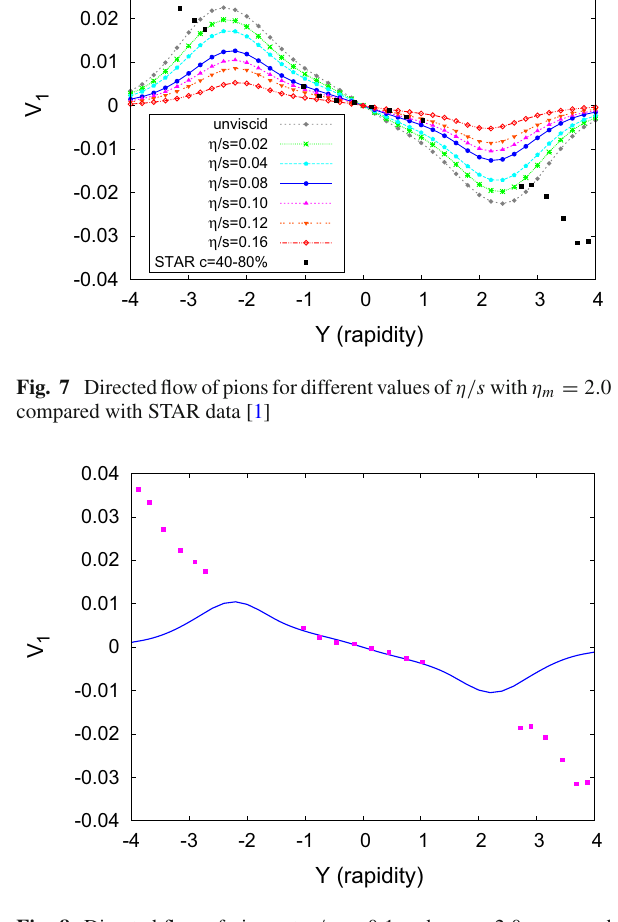
Fig. 8 Directed flow of pions at η/ s = 0 . 1 and η m = 2 . 0 compared with STAR data [1]